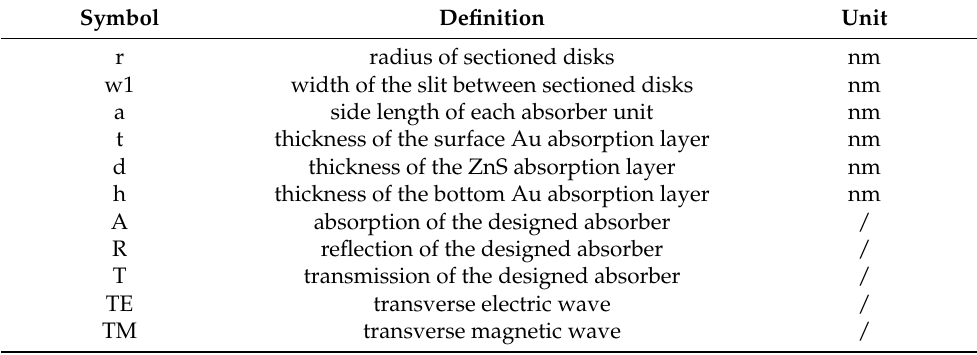
Table 1. Nomenclature table of abbreviations and parameters for the proposed